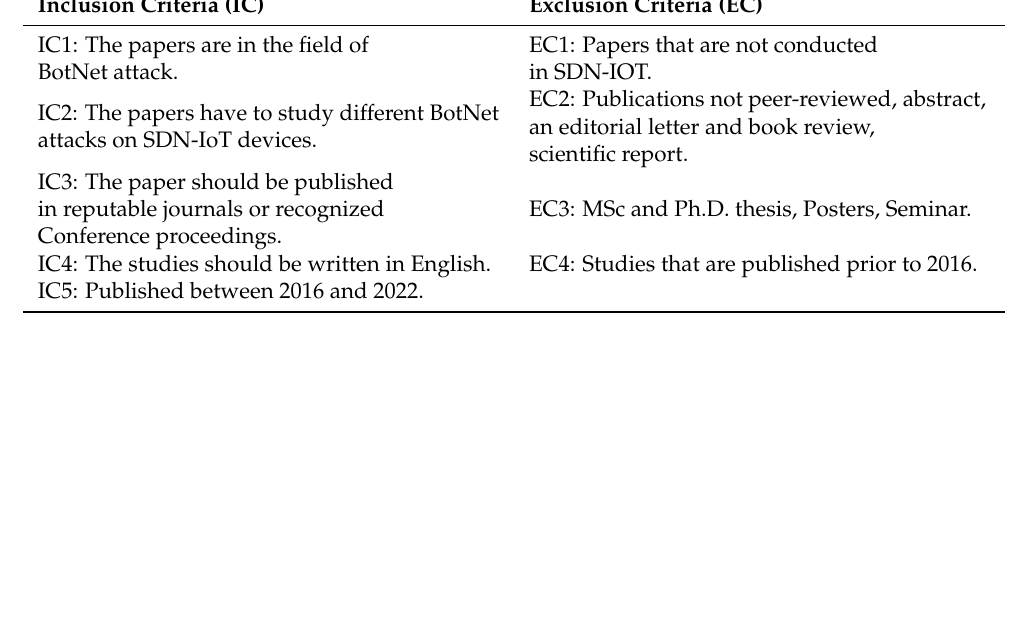
Table 3. Inclusion and exclusion criteria for paper selection. Inclusion Criteria